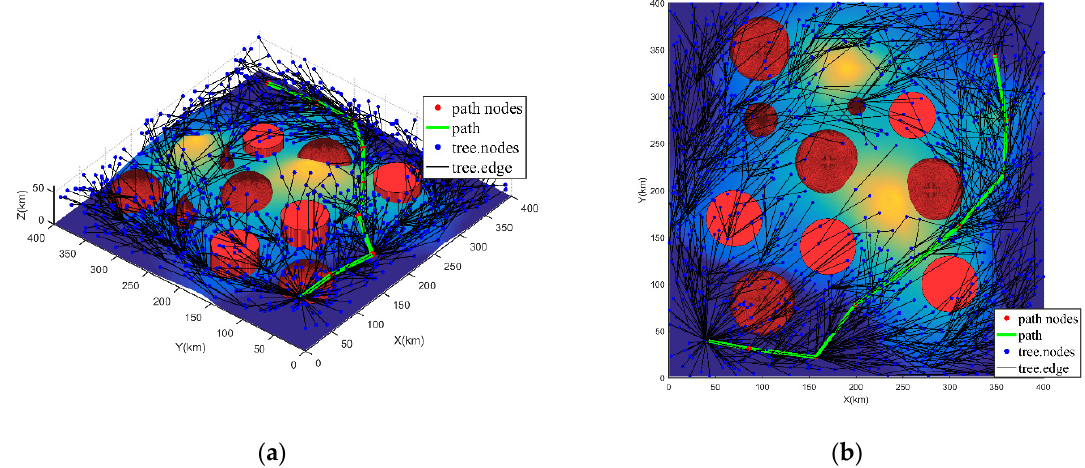
=0.5 and l =0.5: ( a ) 3D view of l t